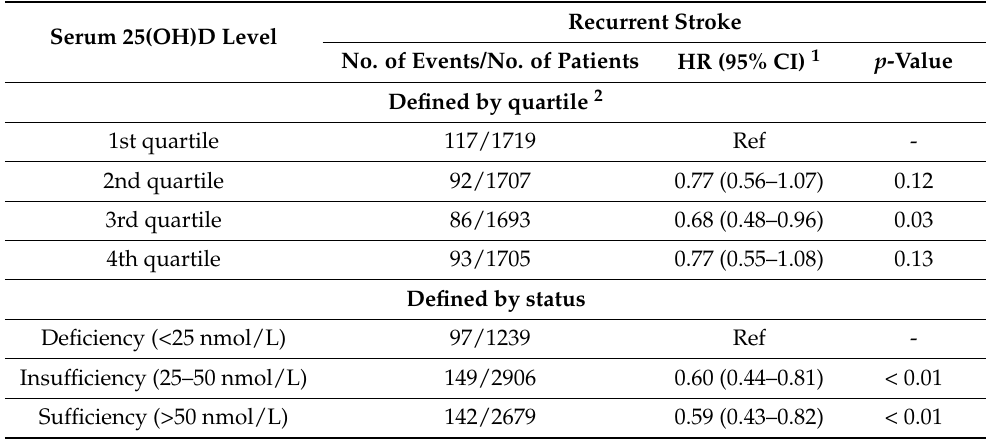
Table 3. Result from additional analyses for the relationship between 25 (OH)D and recurrent stroke risk. Recurrent Stroke Serum 25(OH)D Level No. of Events/No. of Patients HR (95% CI) 1 p -Value Defined by quartile 2 1st quartile 117/1719